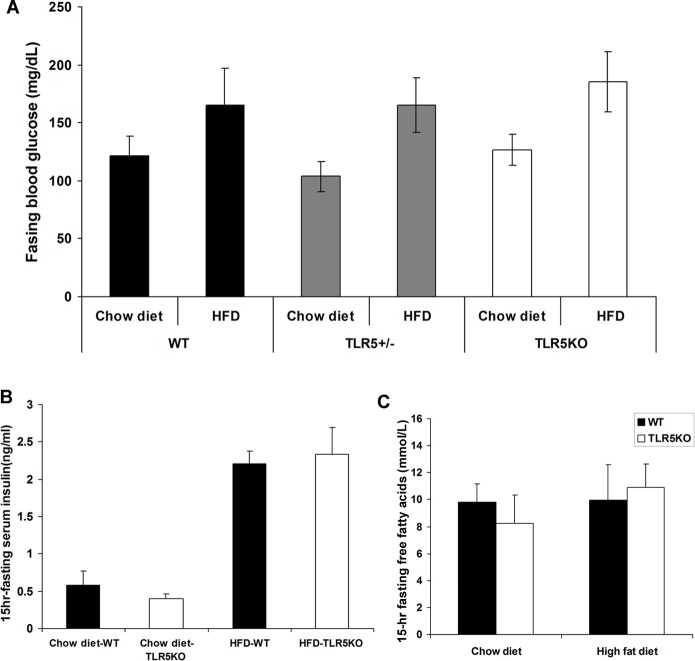
Fasting blood glucose, serum insulin, and lipid profile.A: 15hr fasting blood glucose was measured in wild-type (WT), heterozygous (TLR5+/-), and homozygous TLR5 knockout mice (TLR5KO) fed with either normal chow or a high fat diet. B: serum samples were collected in mice fed with normal chow diet or high fat diet, and insulin levels were measured using-sensitive mouse insulin ELISA kit. C: serum free fatty acids were measured in 20-week-old mice fed with either chow diet or high fat diet for 12 weeks.